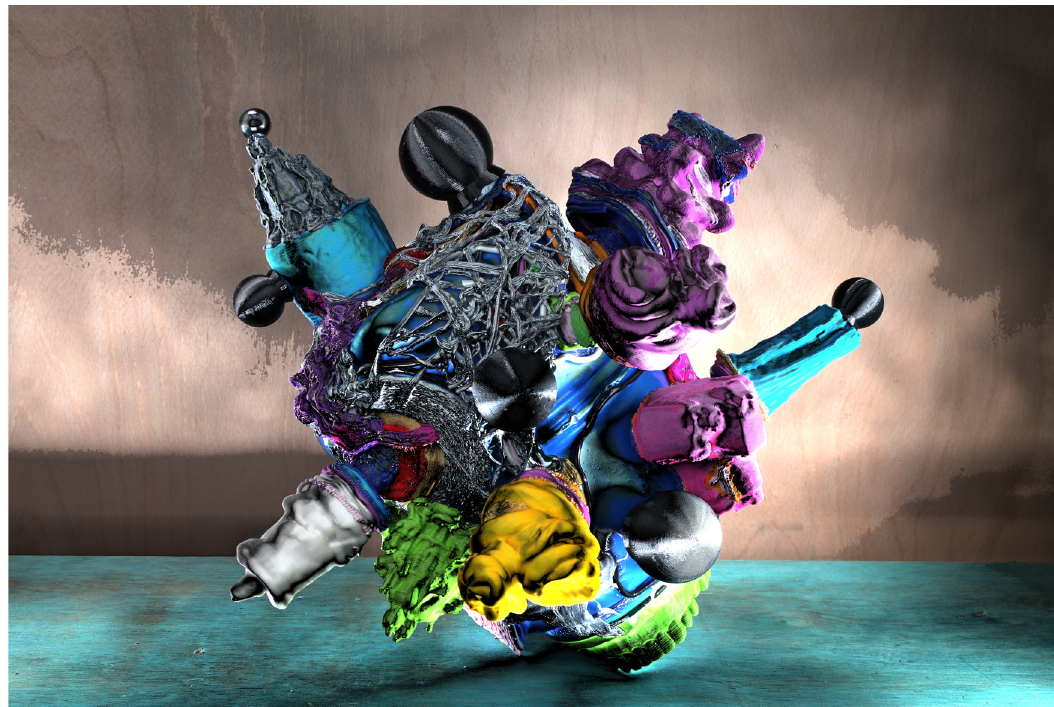
Figure 11: RTI of PLA Assemblage.